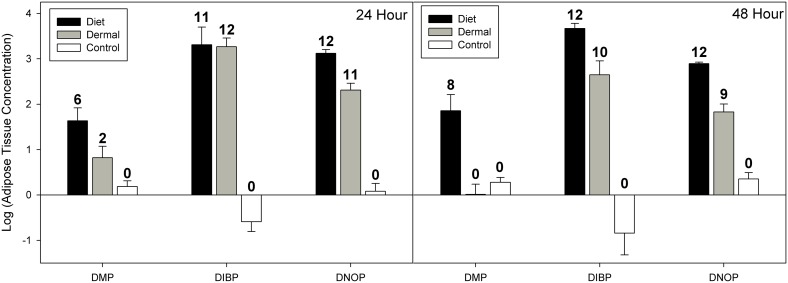
Phthalate concentrations in western fence lizard adipose tissues at 24 and 48 hour time points.Data for 24 hours and 48 hours are presented as log10 means (ng/g ± SE). Phthalate congeners are: di-methyl phthalate (DMP), di-iso-butyl phthalate (DIBP), and di-n-octyl phthalate (DNOP). Linear mixed effects models suggest a significant effect of exposure route (χ2 = 95.21, df = 2, p<0.001) and a significant difference between phthalate congeners (χ2 = 70.96, df = 2, p<0.001), but no significant effect of time (χ2 = 2.05, df = 2, p = 0.15). See text for complete statistical information. Numbers above error bars indicate the number of detections out of 12 samples.